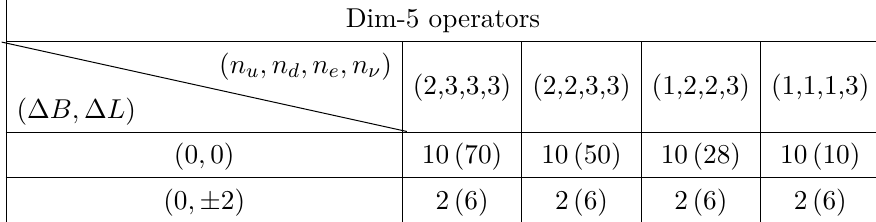
, n , n and n represent active number u d e ν = 2 and u = 3 , 2 , 1 corresponds active e , so the numbers of operators with different flavor 2 L ν L